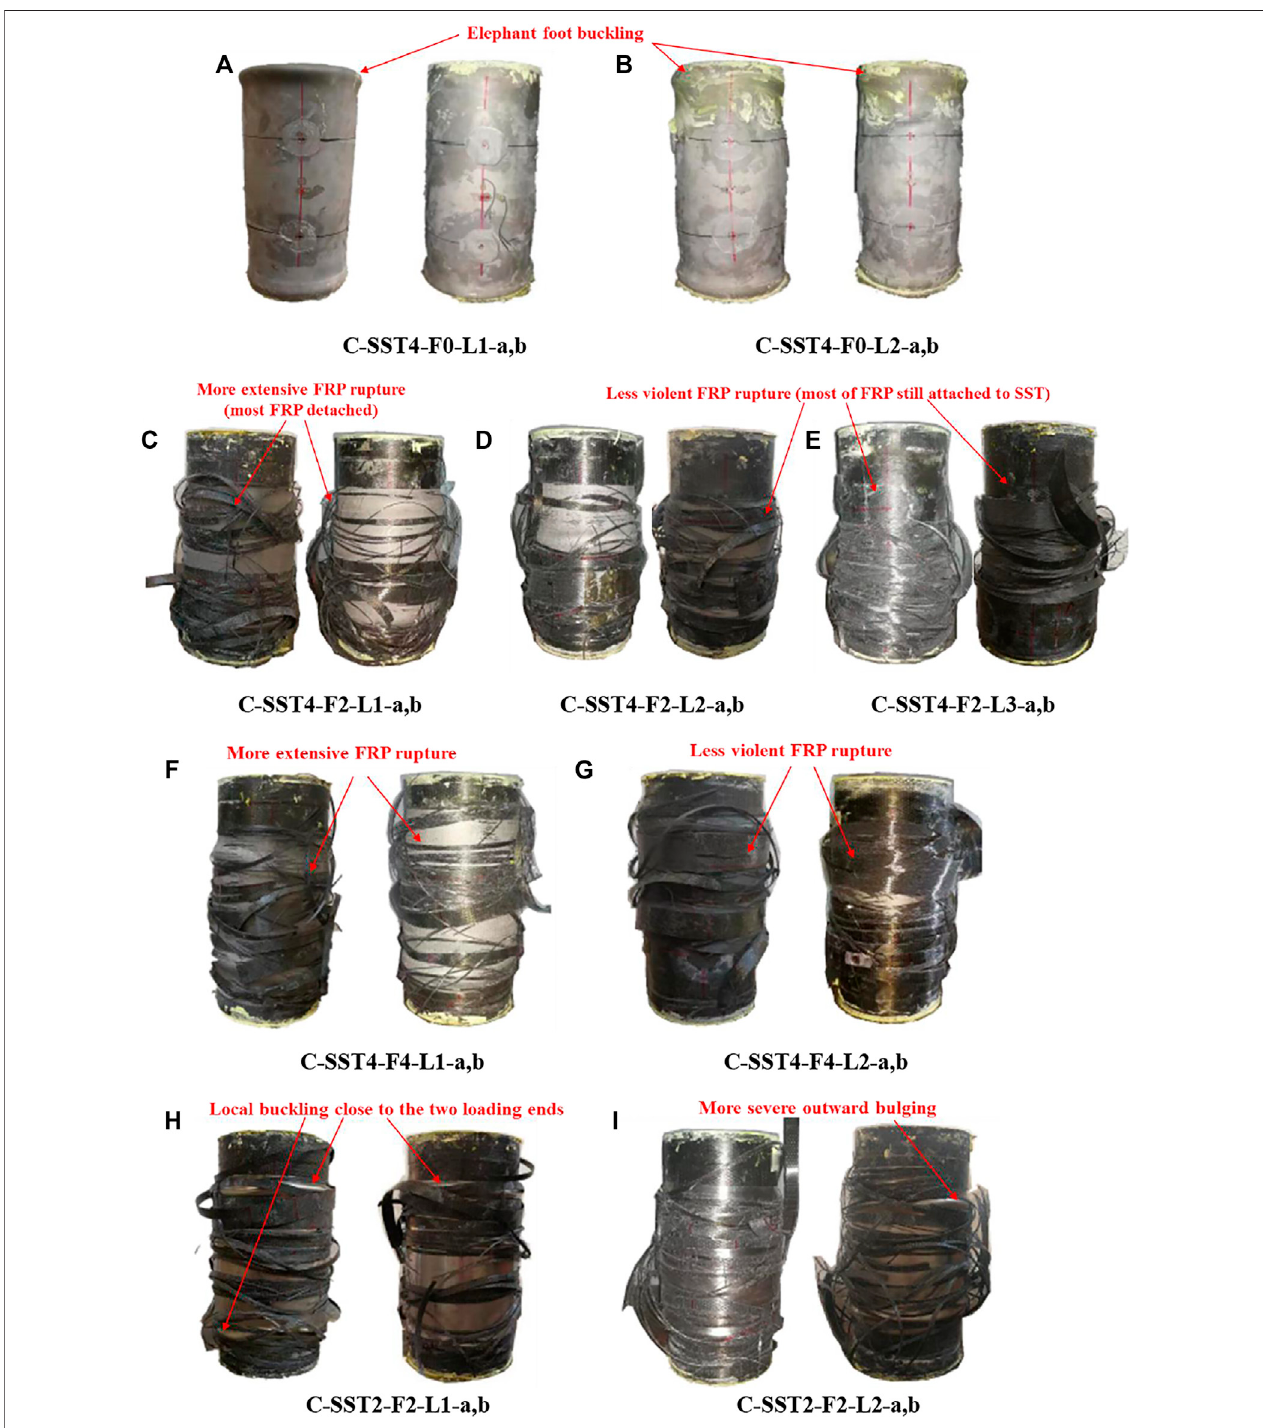
FIGURE4| Failuremodesforthespecimenundercycliccompression. (A) C-SST4-F0-L1-a,b. (B) C-SST4-F0-L2-a,b. (C) C-SST4-F2-L1-a,b. (D) C-SST4-F2-L2- a,b. (E) C-SST4-F2-L3-a,b. (F) C-SST4-F4-L1-a,b. (G) C-SST4-F4-L2-a,b. (H) C-SST2-F2-L1-a,b. (I) C-SST2-F2-L2-a,b.